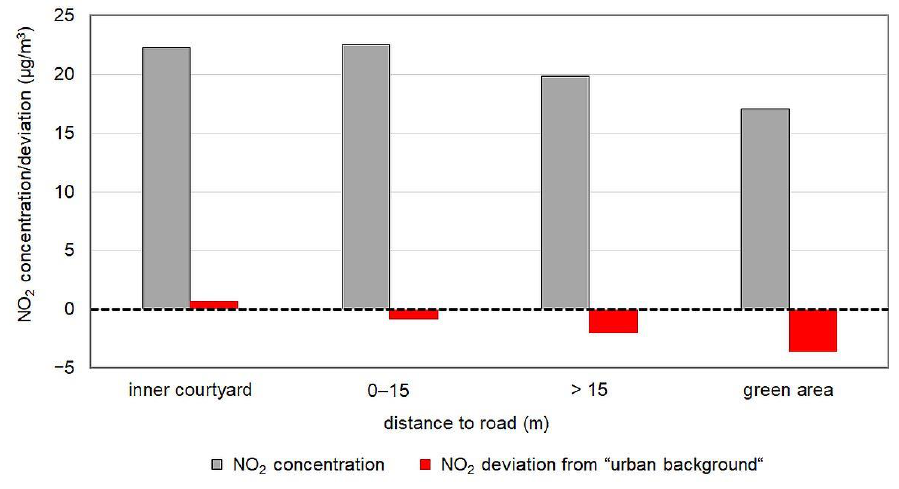
Figure 5. Average NO 2 concentrations and deviation from “urban background” for categories “inner courtyard,” 0–15 m distance to road, >15 m distance to road, and “green area,” from March 2019